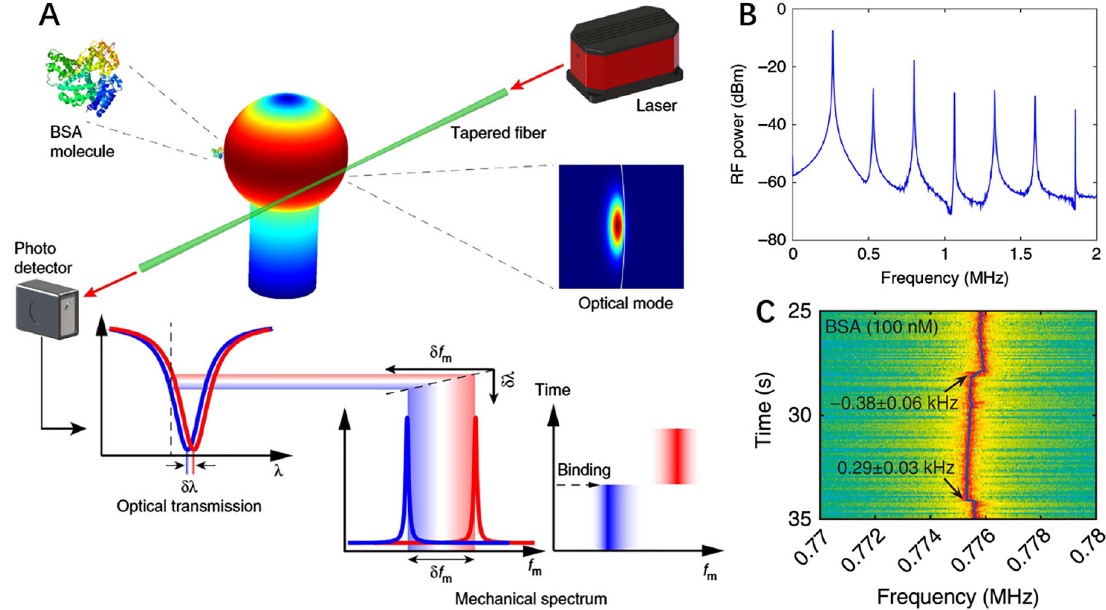
Figure 10: (A) Schematic illustrating the sensing mechanism. When binding the molecules, the optical transmission curve of the optomechanical system drifts from the red line into the blue line. The color map on the microsphere shows the radial breathing mechanical mode simulated by the finite element method. (B) The power spectral density of the cavity transmission. (C) Typical mechanical spectrograms recorded at the third harmonic of the oscillation tone with 100 nM-nominal-concentration protein molecules